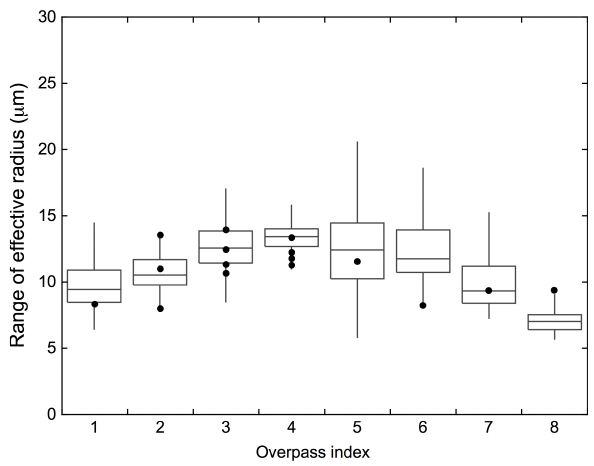
Fig. 12. Box plots of cloud effective droplet radii retrieved from Terra/Aqua MODIS at the ARM Oklahoma site in 2007. Coplotted dots represent cloud-mode 1.5-min average effective radius during the 1-h time window centred at the MODIS overpass time. Detailed information for each overpass can be found in Table 6.